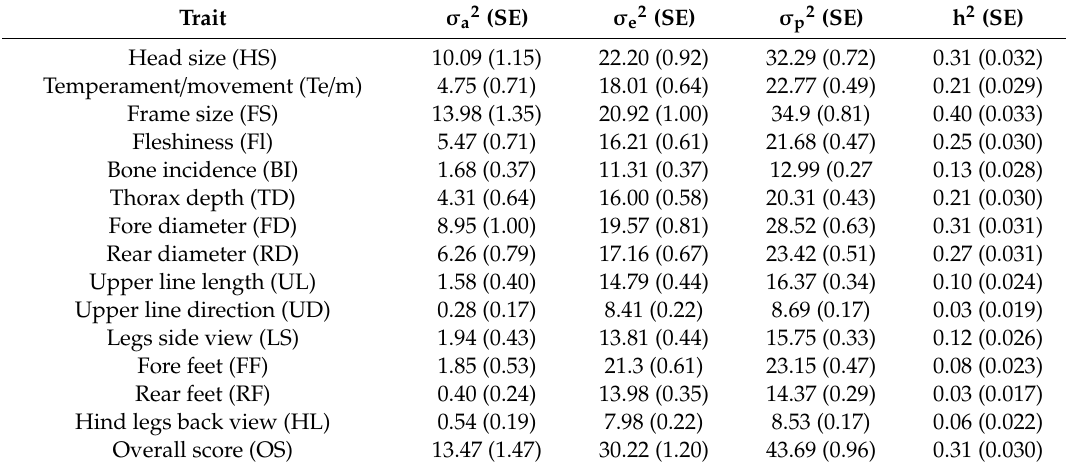
Table 3. Genetic ( σ a2 ), residual ( σ e2 ), phenotypic variance ( σ p2 ), heritability (h 2 ) and their standard errors (SE) for traits under